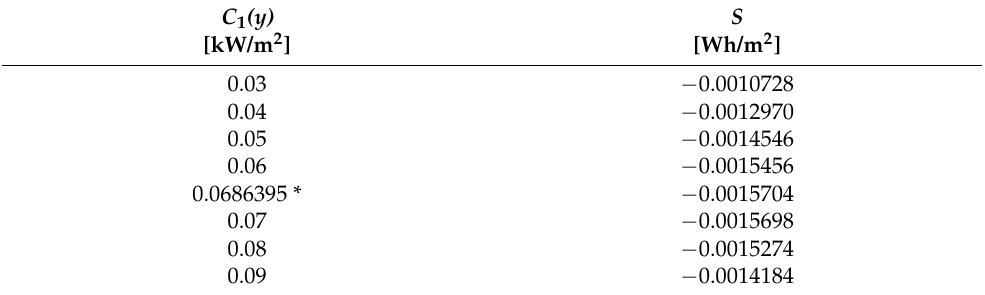
Table 2. Dependence of the energy effect S on the value of C 1 ( y ).